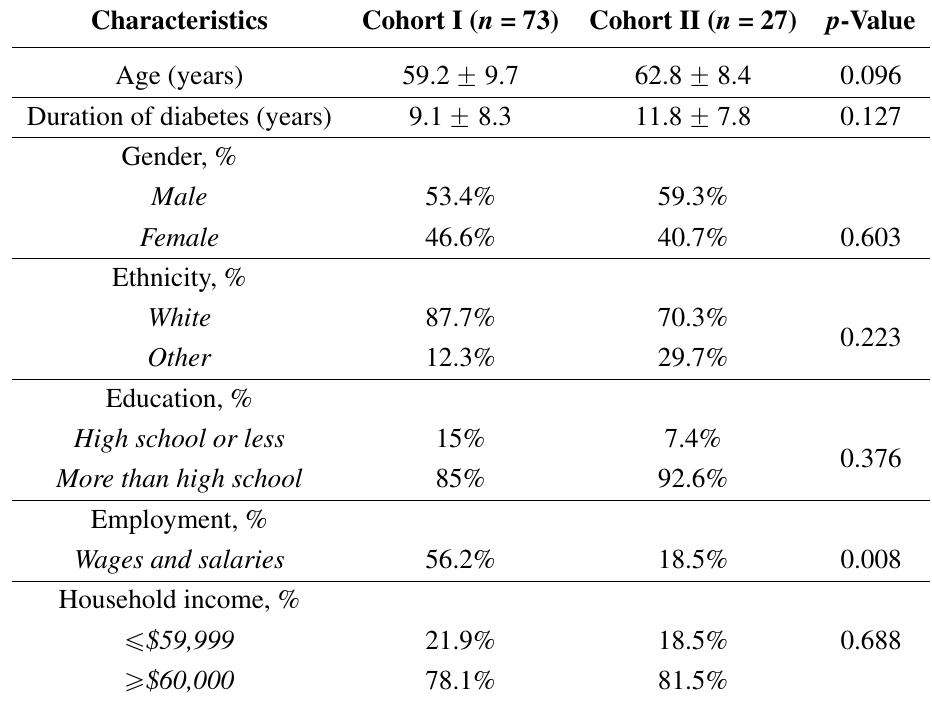
Table 2. Baseline characteristics of the first cohort ( n = 73) and the second cohort ( n =